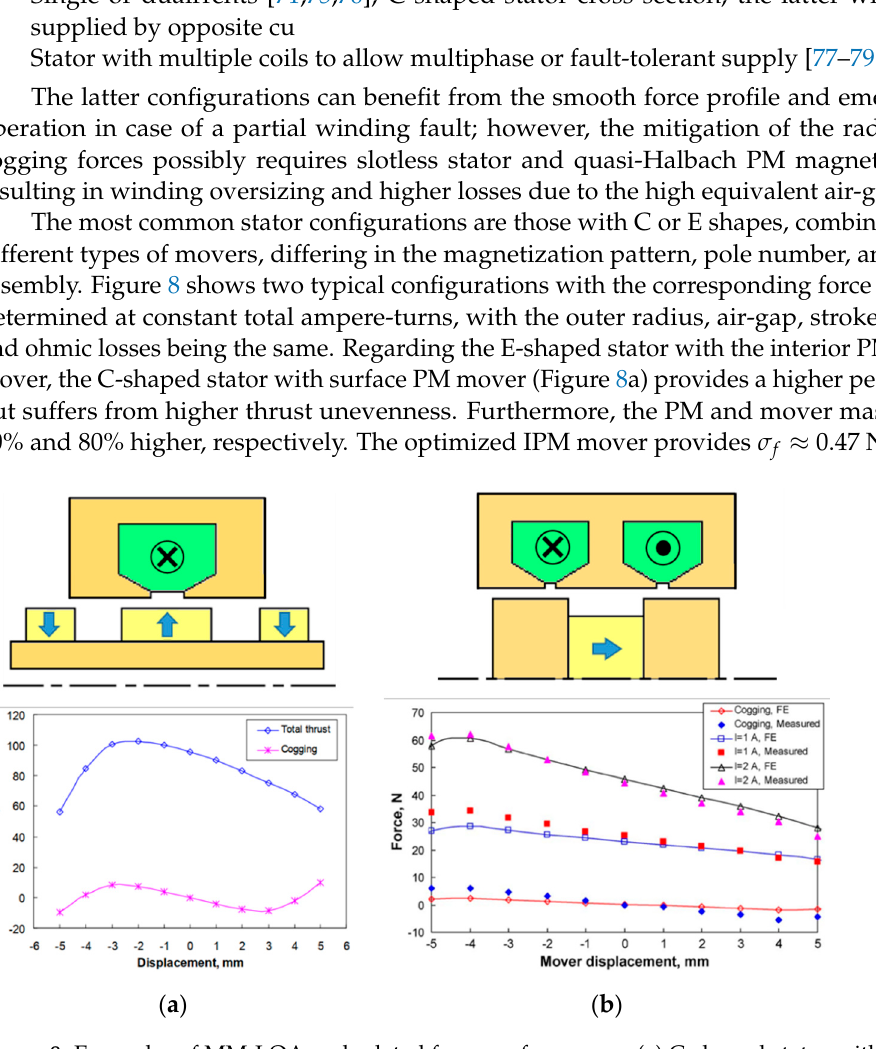
Figure 8. Examples of MM-LOA and related force performances; ( a ) C-shaped stator with surface PM mover [71]; and ( b ) E-shaped stator with IPM mover [71,73] (outer radius: 32 mm, air-gap: 1 mm, and stroke: ± 5 mm). Republished with permission of IEEE.